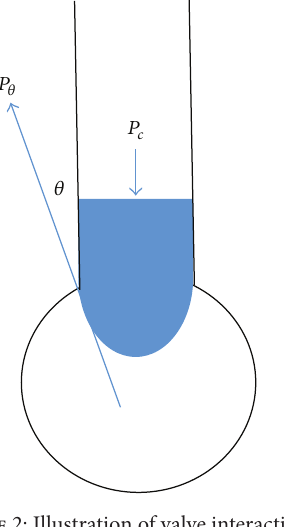
Figure 2: Illustration of valve interaction.